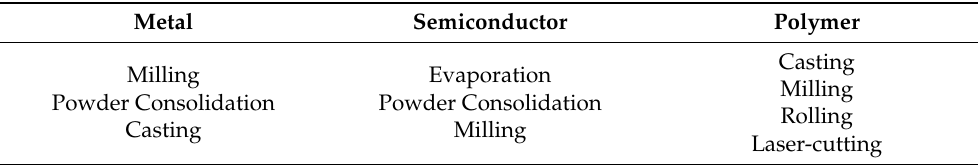
Table 5. Preparation methods of preform constituents of multifunctional